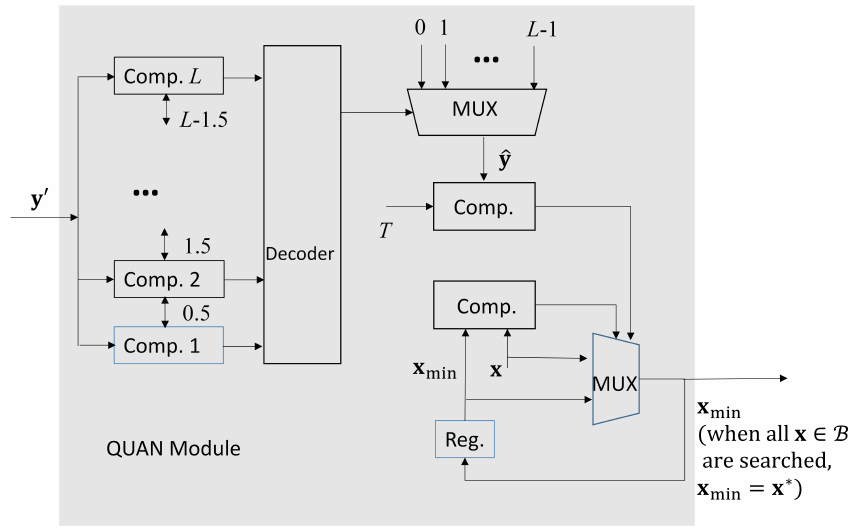
Figure 5. The architecture of the QUAN module.